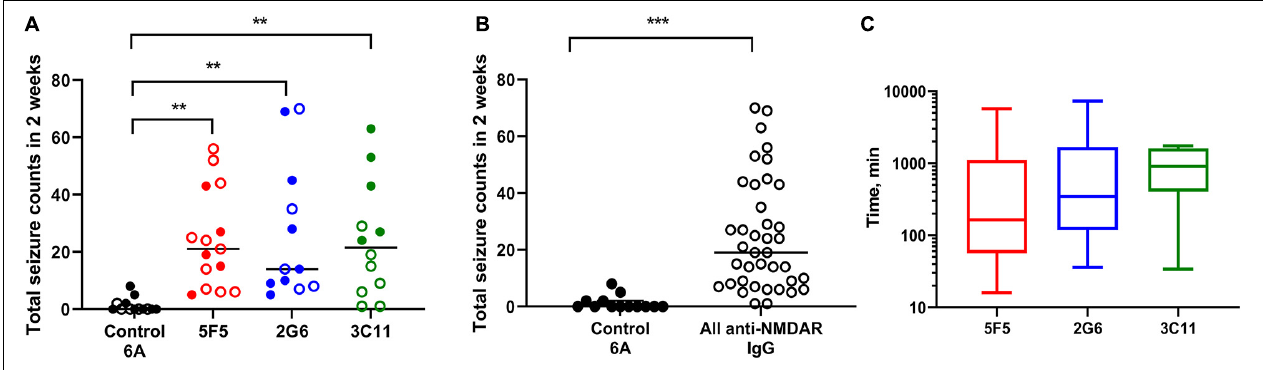
FIGURE 1 | Administration of 5F5, 2G6, or 3C11 monoclonal anti-N-methyl-D-aspartate receptor (NMDAR) antibodies precipitated seizures in mice. (A) Seizure burden was similar in 5F5 ( n = 15, red circles), 2G6 ( n = 12, blue circles) and 3C11 ( n = 12, green circles) antibody-treated groups. Data are median total seizure counts in 2 weeks. ** p < 0.01, ANOVA with Dunnett’s multiple comparisons tests; open cycles, 1X antibodies; filled cycles, 10X antibodies. (B) The distribution of cumulative seizure counts in all anti-NMDAR antibody-treated groups. *** p < 0. 001, t -test. (C) Time to the first seizure was not different between the four treatment groups ( p = 0.39, Kruskal-Wallis test). Data are median latencies. Note log scale on Y axis.